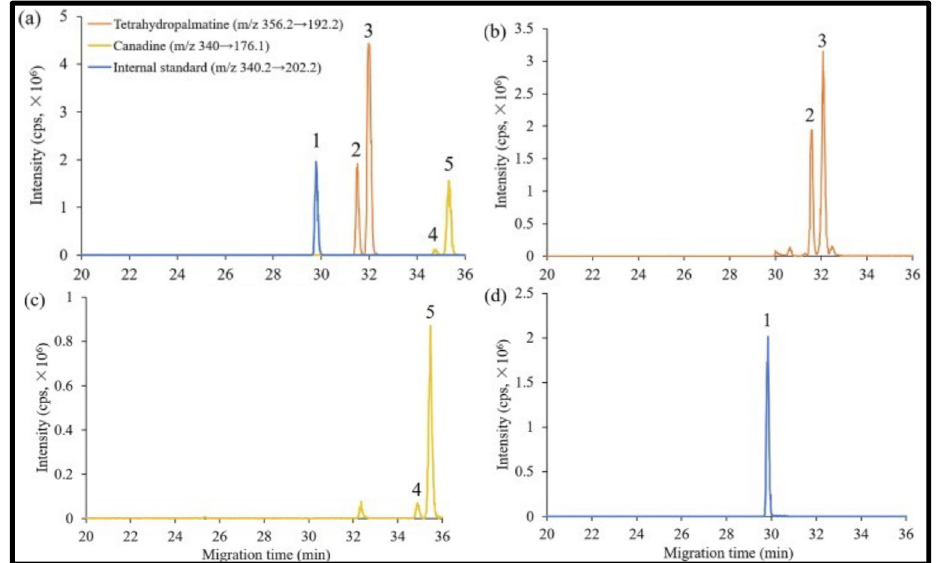
Figure 11. Electropherograms of ( a ) the mixed standard solution (three MRM channels combined) and ( b – d ) the Corydalis Rhizoma extract (three MRM channels plotted separately for a clearer view). Peaks: 1. internal standard; 2. L -tetrahydropalmatine; 3. D -tetrahydropalmatine; 4. ( R )-canadine; and 5. ( S )-canadine. Conditions: 100 cm capillary length, 1.68 min partial filling time (at 10 psi), 20 mM HP- β -CD and 20 mM ammonium formate in 10% ( v / v ) FA solution as BGE, +24 kV effective separation voltage, 0.1% ( v / v ) FA in methanol/water (80:20, v / v ) as chemical modifier with 2 µL/min flowrate. Both Figure and Figure caption were adapted from Yan et al. [33], with permission from Elsevier.